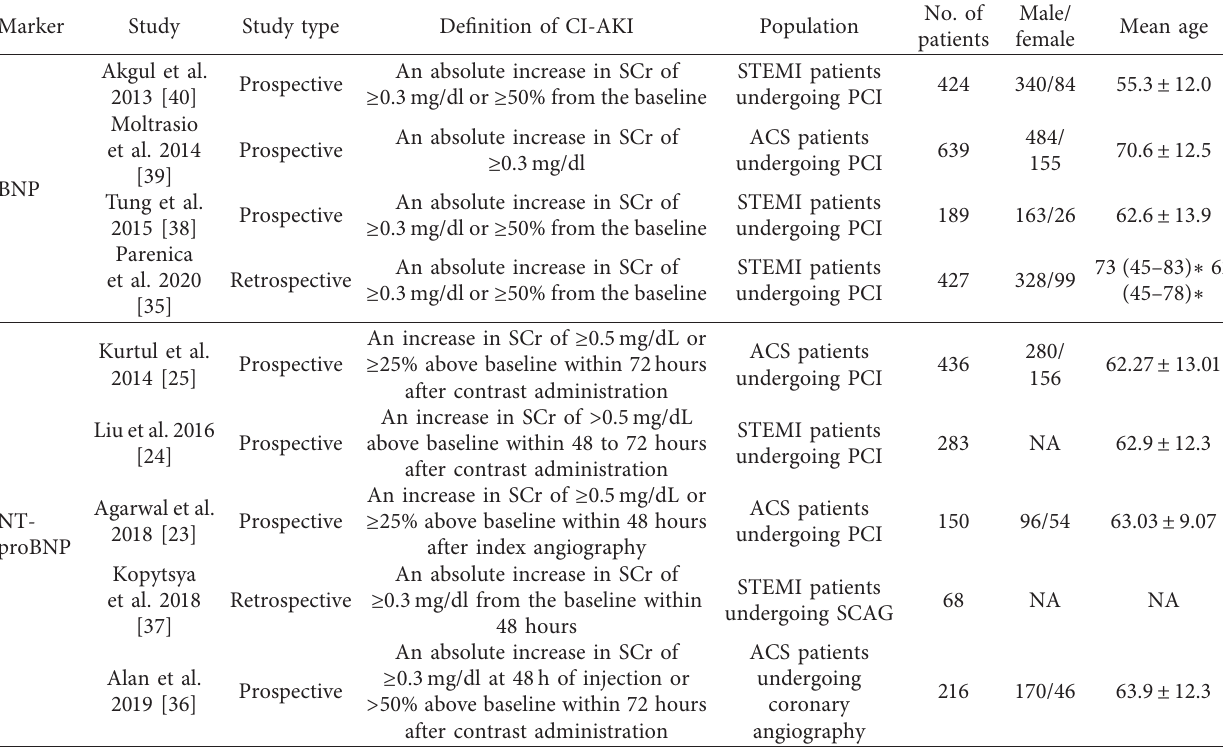
Table 1: Characteristics of included studies.